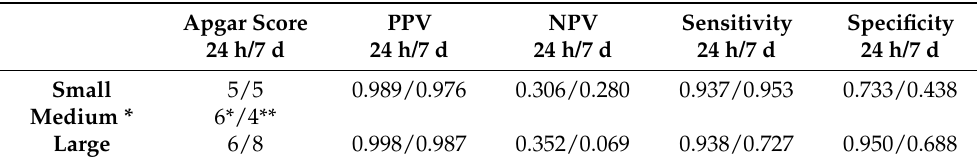
Table 9. Apgar cutoff values for survival at 24 h and 7 days (d) of age according to BBS (small, medium, large), with the positive predictive value (PPV), negative predictive value (NPV), sensitivity and specificity.